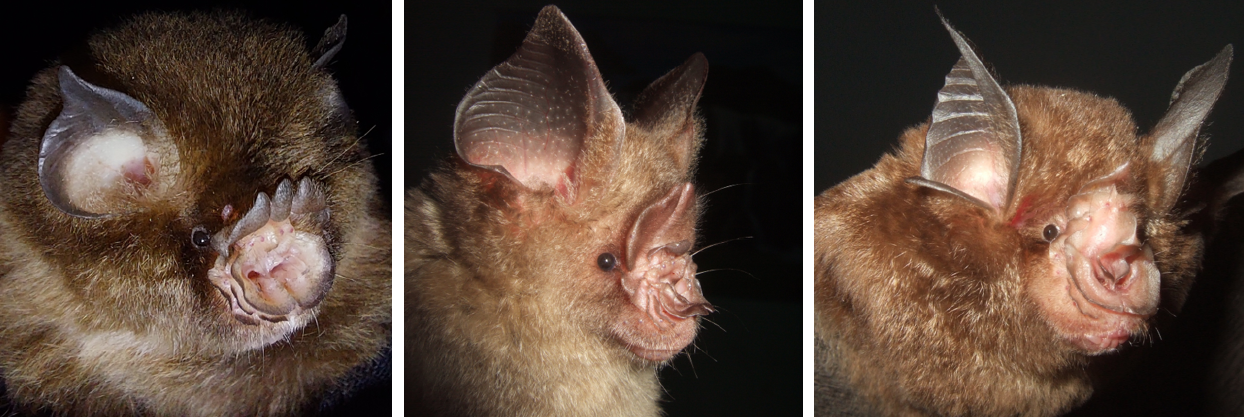
Figure 3. Frontolateral view of CF bat species: A. stoliczkanus ( left ), H. scutinares ( center ) and R. thomasi ( right ). Photos: Vu Dinh Thong.